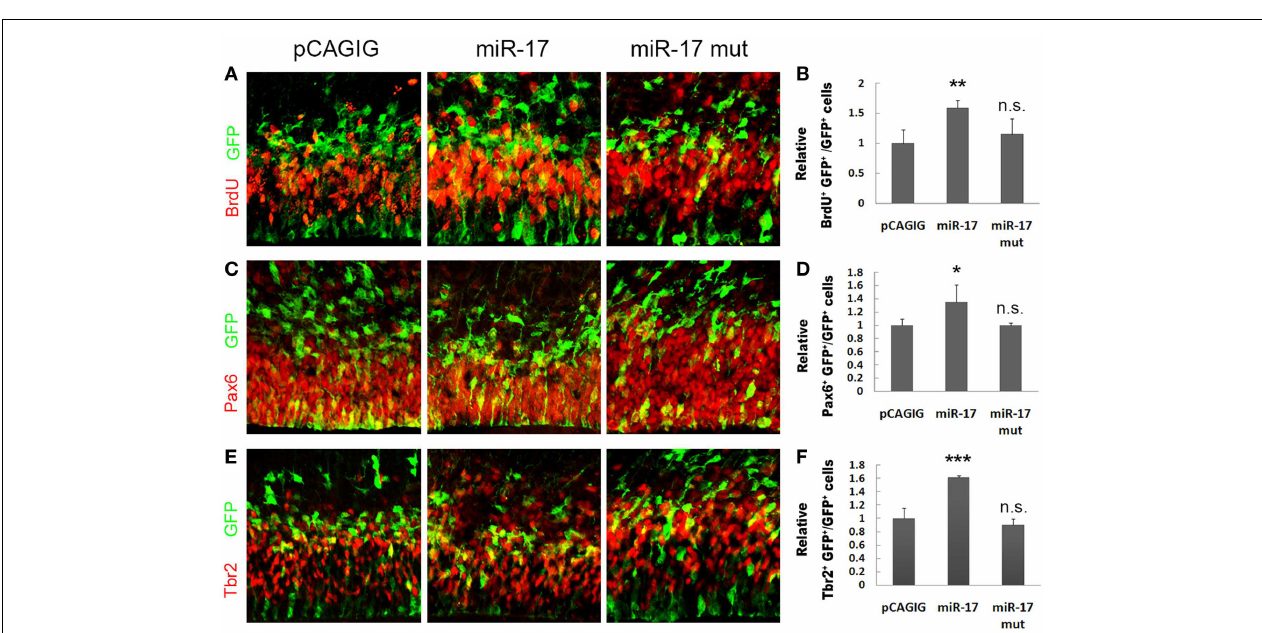
FIGURE 3 | p21 is a putative target of miR-17 . (A) A predicted targeting site of miR-17 on the 3 (cid:48) UTR of p21 . (B) Luciferase activities of the p21 3 (cid:48) UTR construct were greatly reduced by miR-17, but not by miR-17 mutation or a control microRNA miR-9. miR-17 had no effect on pGL4.13 construct in which the p21 3 (cid:48) UTR had been removed. (C) The expression